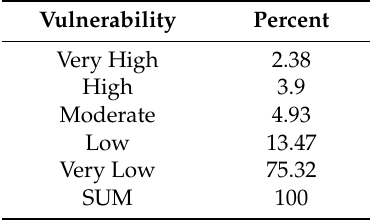
Figure 7. Residential buildings vulnerability distribution showing structural and geotechnical vulnerability in Tabriz municipality. 4. Discussion The vulnerability is multi-dimensional, differential and varies across physical space and within social groups. In addition, it is scale-dependent with regards to space and units of analysis such as individual, household, region, or system with dynamic characteristics and driving forces of vulnerability change over time. Vulnerability assessment is a broad concept that can be discussed in several different contexts. However, it is not a variable that can be measured directly but can be assessed indirectly according to a set of dimensions. For assessing urban vulnerability, it is necessary to consider all main dimensions of vulnerability including environmental, physical and socio- economic [71,72]. Physical factors are usually materially oriented arising from the field of engineering, architecture and land use planning. Vulnerability from a physical perspective, despite its broad scope,